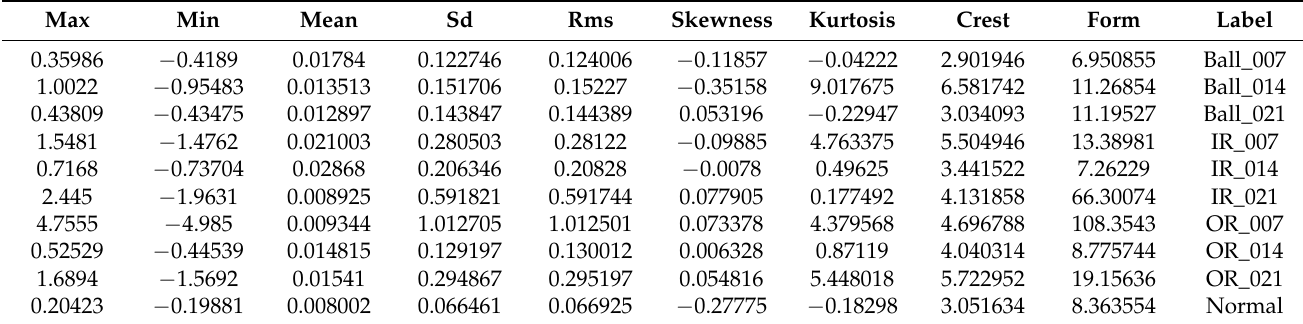
Table 2. There are 9 features calculated in the original vibration data for 10 categories of labels, 230 labels for each category, a total of 2300 data.